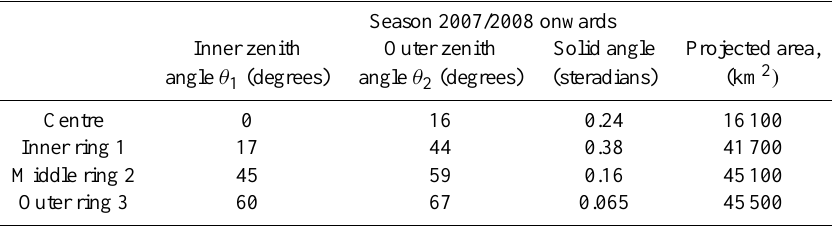
Table 3. A table showing the inner and outer zenith angles for each ring, and the associated solid angles. From the second winter (2007–2008) onwards the SCANDI zones were divided according to roughly equal area projected on the sky, except for the central